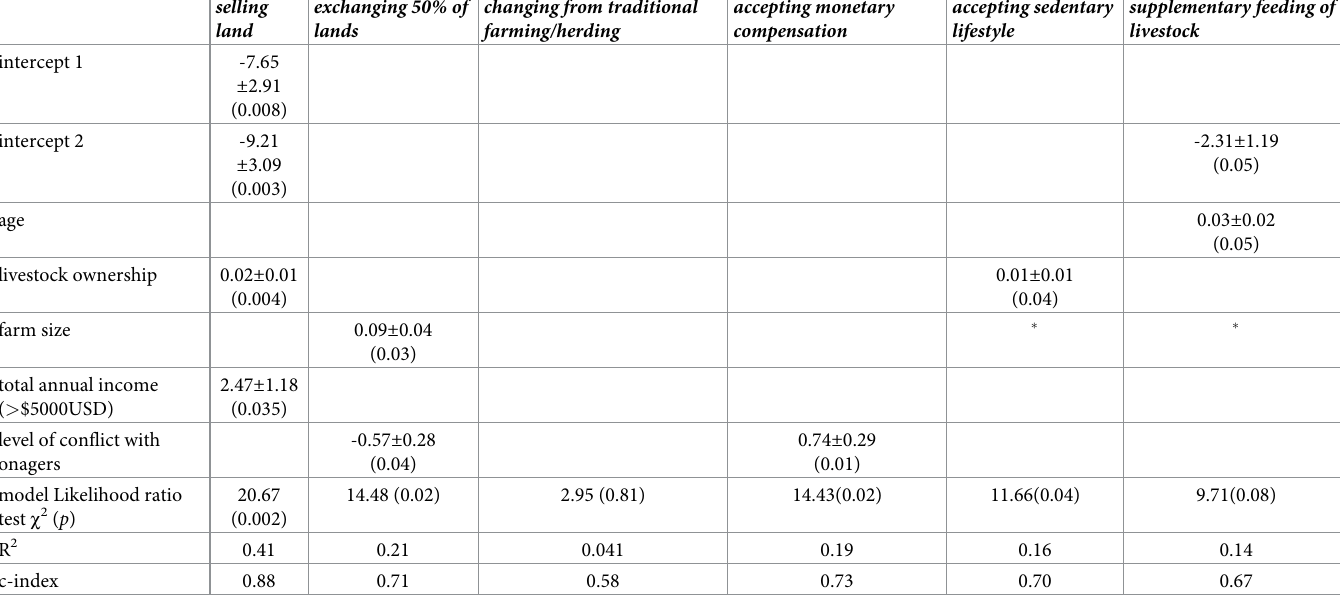
Table 4. Parameter estimates ( β ± SE) and p-values (p) results of ordinal regression models to predict effects of socio-economic variables and level of conflict with onagers on accepting potential management strategies aimed at reducing human-onager conflict within Bahram-e-Goor Protected Area (BPA), Iran. Strategies included: (1) selling land to the government; (2) exchanging 50% farmland/pastureland within BPA for an equivalent amount of land outside BPA; (3) changing from a tra- ditional farming/herding lifestyle to industrialized farming (for farmers) or livestock production (for herders) with the help of government;(4) accepting monetary com- pensation to tolerate onager conflict; (5) accepting a sedentary lifestyle instead of a nomadic one; and (6) supplementary feeding of livestock for a period in the year with the help of the government. selling exchanging 50% of changing from traditional land lands